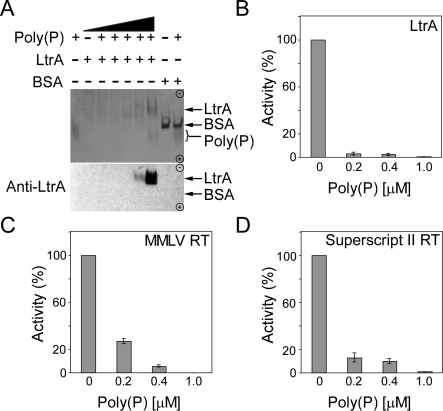
Poly(P) Binds to LtrA and Inhibits its RT Activity(A) Nondenaturing PAGE. LtrA protein (100 pmol) by itself or mixed with different amounts of poly(P) (1 pmol, 10 pmol, 100 pmol, 1 nmol, and 10 nmol) was run in a nondenaturing 5–15% polyacrylamide gradient gel. Bovine serum albumin (100 pmol; BSA) by itself or mixed with10 nmol poly(P) was run in parallel lanes. The gel was silver-stained, and a parallel gel (below) was blotted to nitrocellulose and probed with anti-LtrA antibody (see Materials and Methods section).(B–D) RT assays. RT activity was assayed by incubating 200 nM LtrA or dilutions of Moloney murine leukemia virus or Superscript II RT (Invitrogen) having equivalent activity with [32P]-dTTP and poly(rA)/oligo(dT)18 in reaction medium containing 10 mM KCl, 10 mM MgCl2, and 50 mM Tris-HCl, pH 7.5, for 10 min at 37 °C in the presence or absence of 0.2, 0.4, or 1 μM poly(P). Polymerization of [32P]-dTTP was measured as described in the Materials and Methods section and [50]. For all three enzymes, RT activities were 20,000–100,000 cpm, and incubation times were verified to be in the linear range. The bar graphs show the mean activity for three independent determinations, with the error bars indicating the standard deviation.